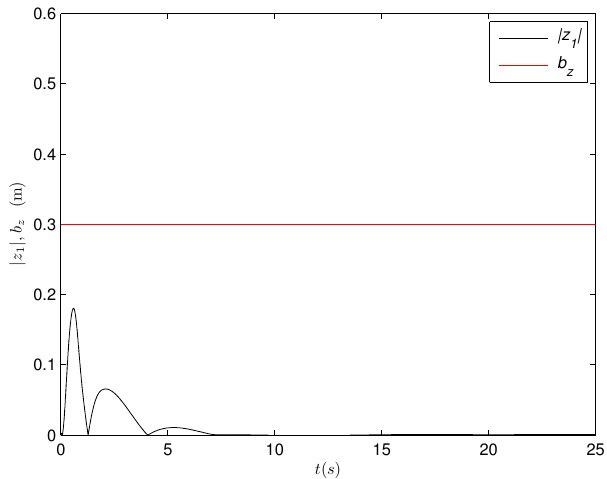
Figure 4. Deferred output error constraint (output feedback barrier adaptive control).